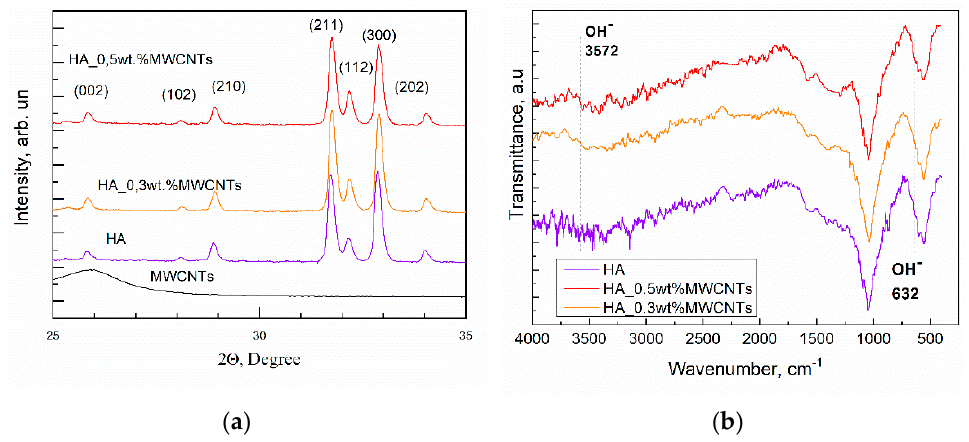
Figure 3. XRD patterns of MWCNTs and composite ceramics HA-0.3 wt.%MWCNTs synthesized at a temperature of 1100 °C in argon atmosphere ( a ). FT-IR spectroscopy of HA-0.3 wt.%MWCNTs ceramics synthesized at a temperature of 1100 °C in argon atmosphere ( b ). Hydroxyapatite (HA) without additives of multi-walled carbon nanotubes (MWCNTs) and HA with 0.5 wt.% MWCNTs are added for comparison [25].